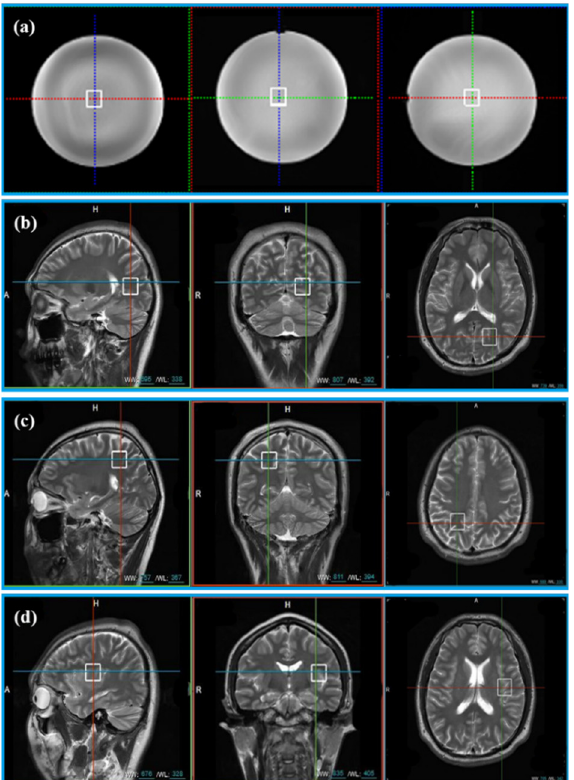
Figure 2. The location of voxels acquired from phantom and 11 healthy volunteers. ( a ) Voxel location of the phantom; ( b ) voxel LA, ( c ) voxel LB, and ( d ) voxel LC are the voxel locations of 11 healthy subjects.